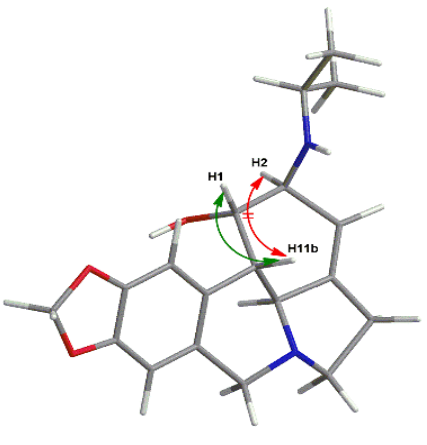
Figure 1. NOESY analysis of 9e